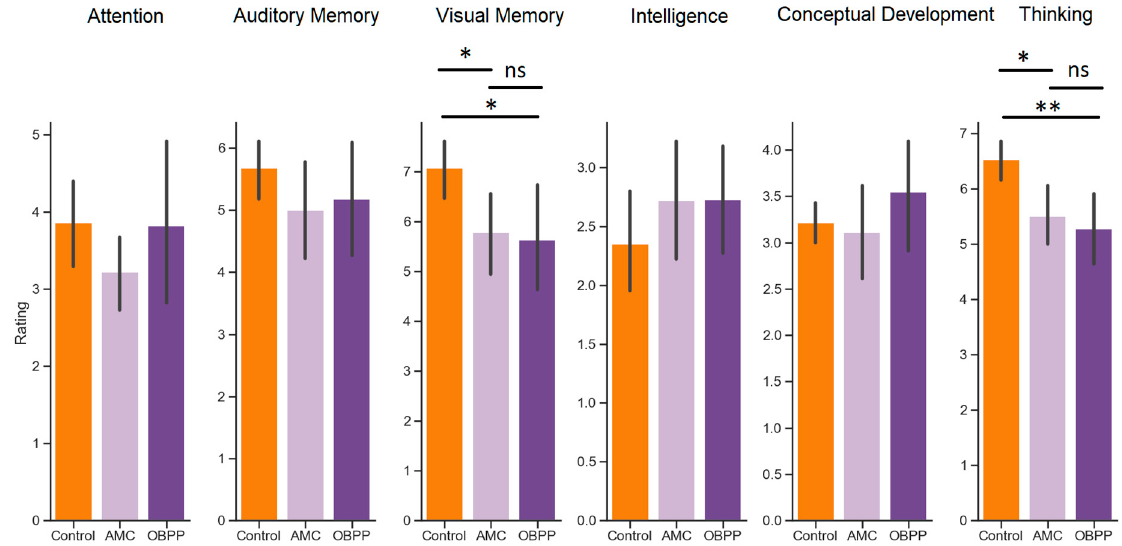
Figure 2. Performance in cognitive tasks assessed for AMC patients (light purple), OBPP patients (dark purple), and control children (orange). Asterisks between the bars indicate the significant difference shown by post hoc Mann–Whitney comparisons between two groups (* p < 0.05; ** p < 0.01, ns: not significant).